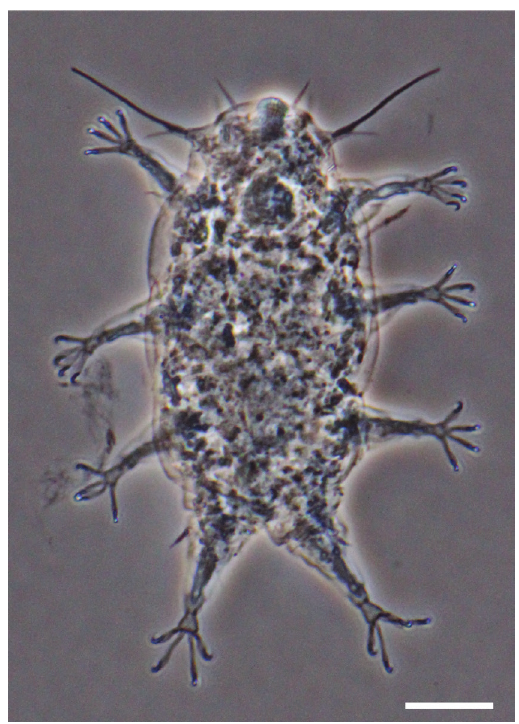
Figure 1. Phase contrast micrograph of Dipodarctus sp. Scale bar = 20